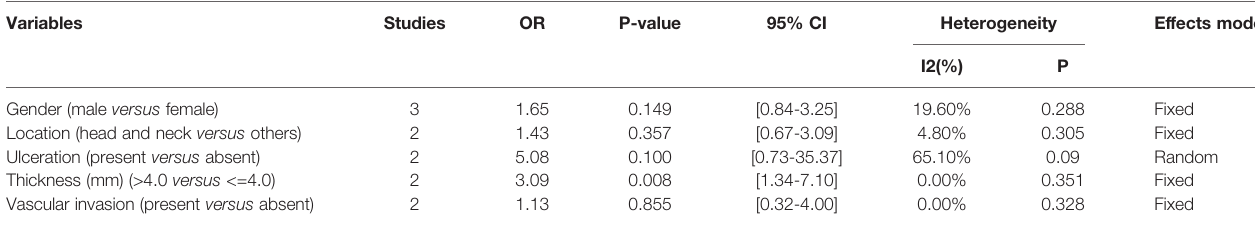
TABLE 5 | The relationships between Ki-67 expression and clinicopathologic parameters.